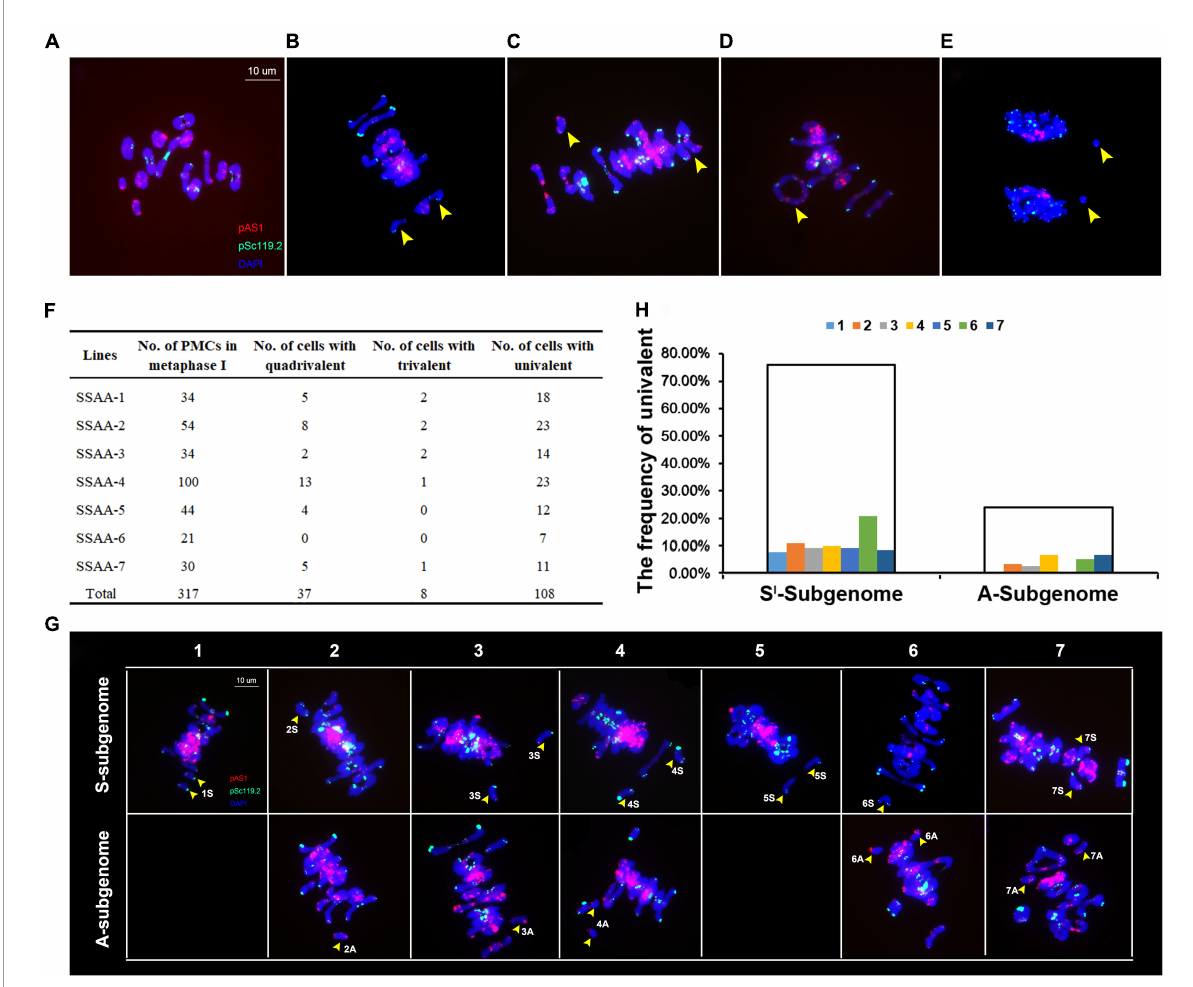
FIGURE6 Cytological chromosome behavior at metaphase and anaphase of meiosis I of pollen mother cells (PMCs) taken from seven bona fide euploid individuals randomly chosen at S4. (A) Normal chromosome pairing at metaphase I, in which 14 bivalents were formed via exclusive homologous chromosome pairing. (B) Two univalents at metaphase I. (C) A univalent and a trivalent at metaphase I. (D) A quadrivalent at metaphase I. (E) Lagging univalents at anaphase I. The FISH images were probed by pAs1 (red) and pSc119.2 (green), and counterstained by DAPI. Yellow arrows denote abnormal chromosome pairing (univalent or multivalents) and disjunction. (F) Tabulated PMCs showing chromosome pairing behavior at metaphase I. (G) FISH images illustrate univalents (yellow arrows) of each of the 14 chromosome pairs of both S l and A subgenomes at metaphase I. The pAs1 (red) and pSc119.2 (green) were used as FISH probes. (H) The frequencies each of the 14 chromosome pairs of both S l and A subgenomes showing